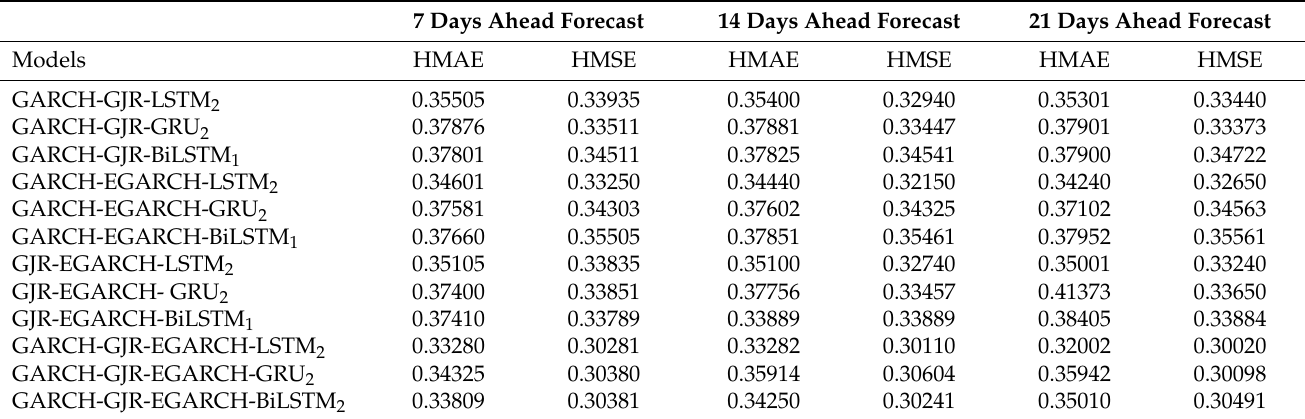
Table 4. Out-of-sample forecasts results for GARCH-type double and triple models, hybrid with DL